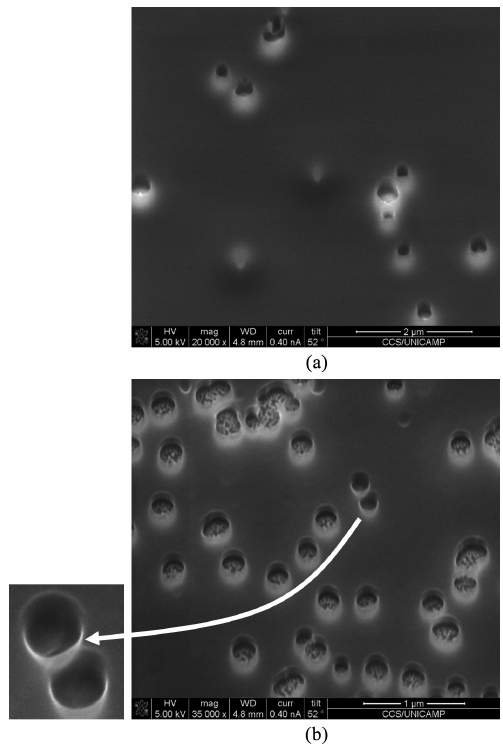
Figure 4. SEM images of structures grown at 64 mTorr C onto 3 nm Ni (a) and Cu (b) catalytic films.(Samples 64Ni and 64Cu).